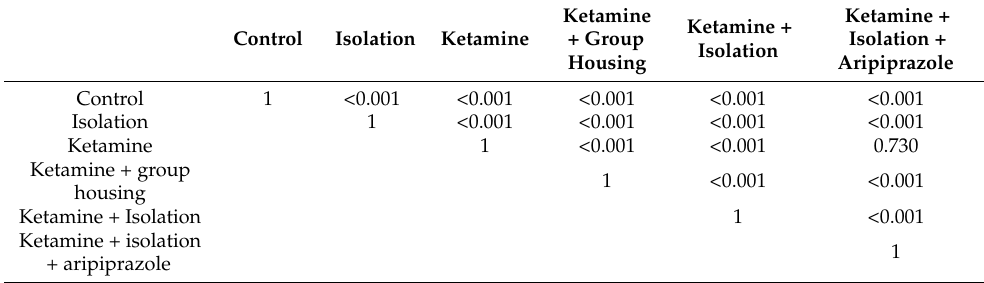
Figure 1. Behavioral results in the open field test of the six analyzed groups based on the number of line cross- ings. The values are mean. Group 1—control, Group 2—social isolation, Subgroup 3a—ketamine (30 min after injec- tion), Subgroup 3b—ketamine (end of study), Subgroup 4a—isolation + ketamine (3 weeks after isolation), Subgroup 4b—isolation + ketamine + aripiprazole treatment (6 weeks from the starting point). * Significantly different when compared to control group ( p < 0.05). Table 1. All p -values for the number of line crossings in the open field